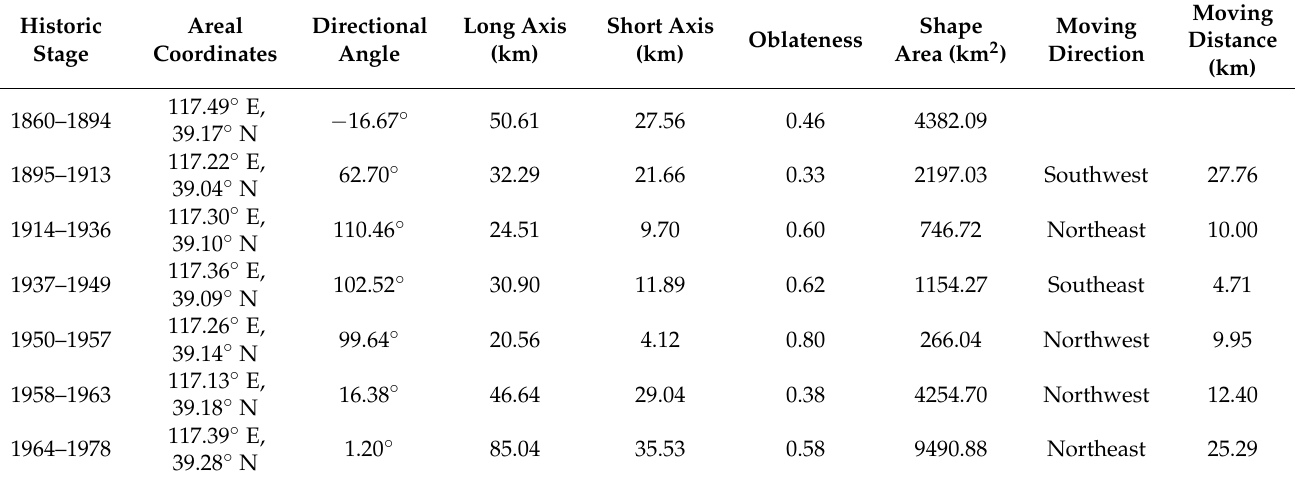
Table 3. Spatial distribution’s centre of gravity and standard deviation ellipse parameters by